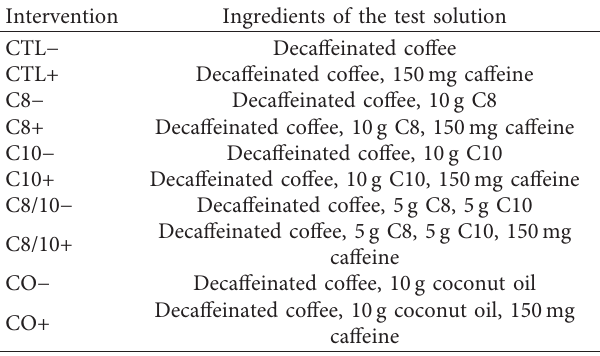
Table 1: A description of the test solutions. Intervention Ingredients of the test